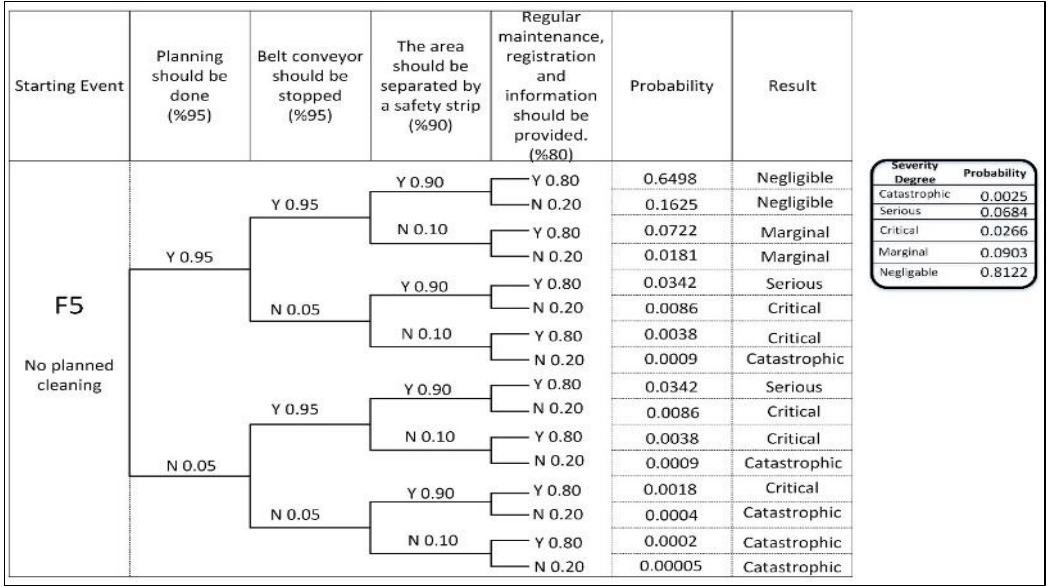
Figure 9: Event tree analysis diagram of F5.